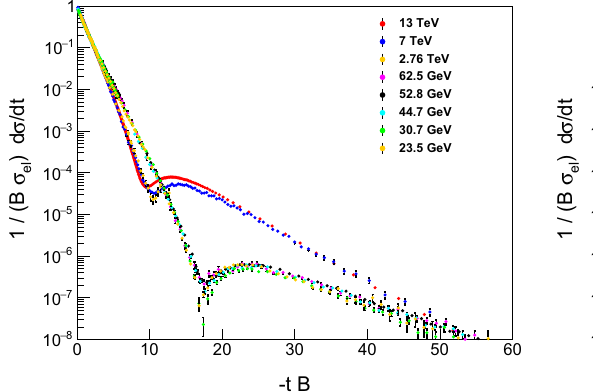
statistical errors only. (Right panel): Same data set, but now showing both statistical and t -dependent systematic errors added in quadrature